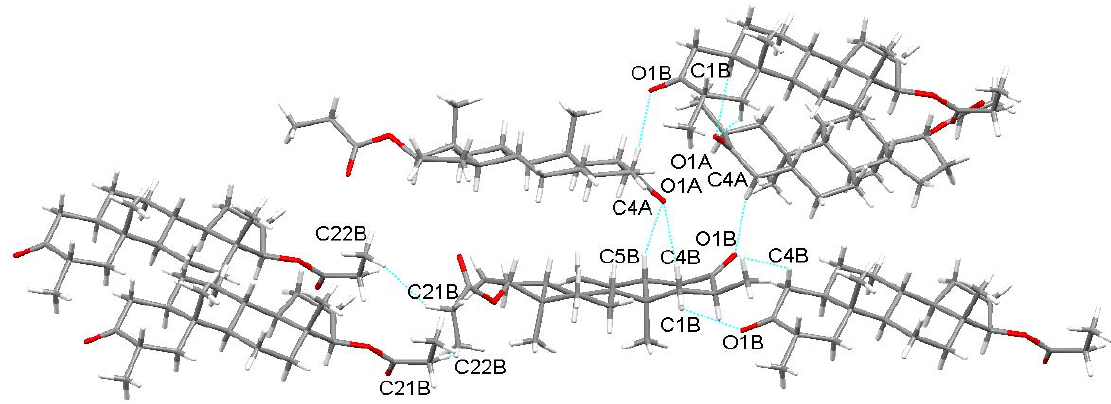
Figure 5. Short contact interactions in Drost 3.